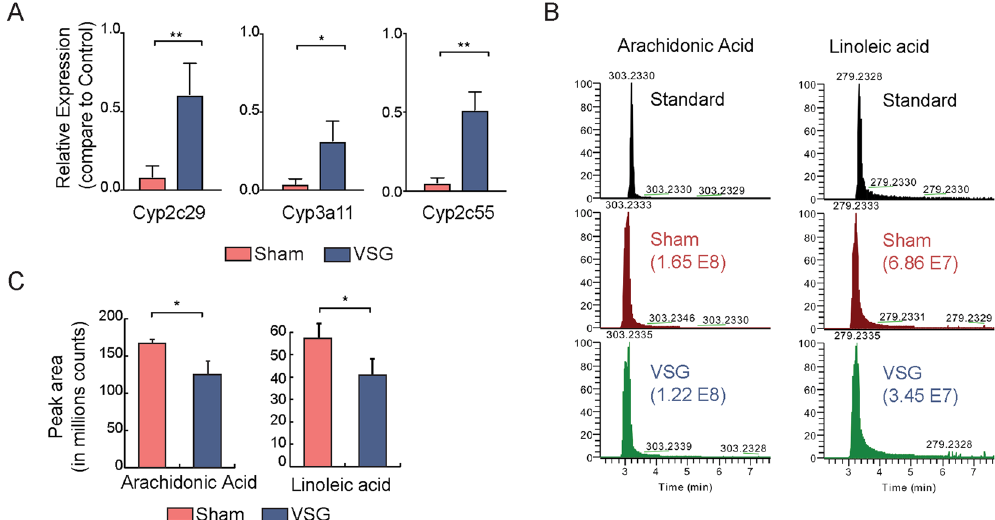
Figure 4. Altered omega-6 metabolism by VSG. ( A ) Relative expression levels of Cyp 2b29 Cyp 3a11, and Cyp 2c55 in Sham and VSG compared to Control mice liver. Expression levels were defined by RT-qPCR. ( * Indicates p < 0.05, ** Indicates p < 0.01) ( B ) Representative chromatogram of arachidonic acid and linoleic acid from standards and liver tissues of Sham and VSG mice. Numbers in parentheses represent peak area. ( C ) Peak area from mass spectrometry of arachidonic acid and linoleic acid in Sham and VSG mice liver ( * Indicates p < 0.05, ** Indicates p < 0.01; t